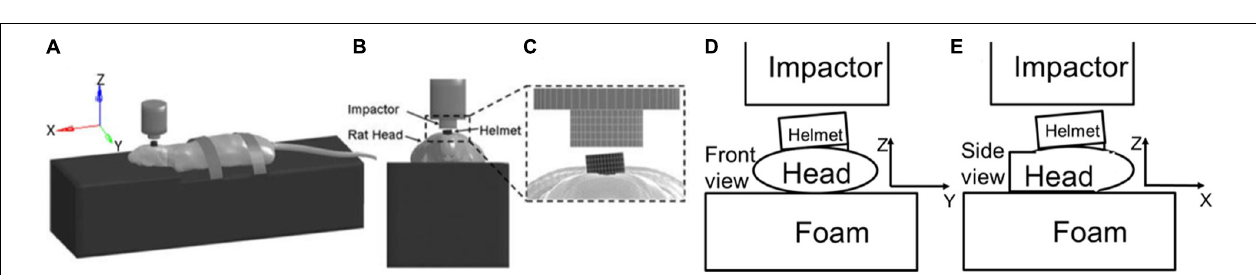
FIGURE 4 | FE model sections throughout the cc and brainstem tracts with MPS contour corresponds to experiment sections of TAI counts. (A) One TAI coronal section of cc; (B) Showing an example of TAI count within four 0.2 × 0.2 mm grids from a coronal section.